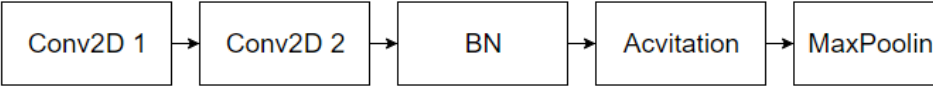
Figure 2. The overall architecture of the proposed CNN Blocks.